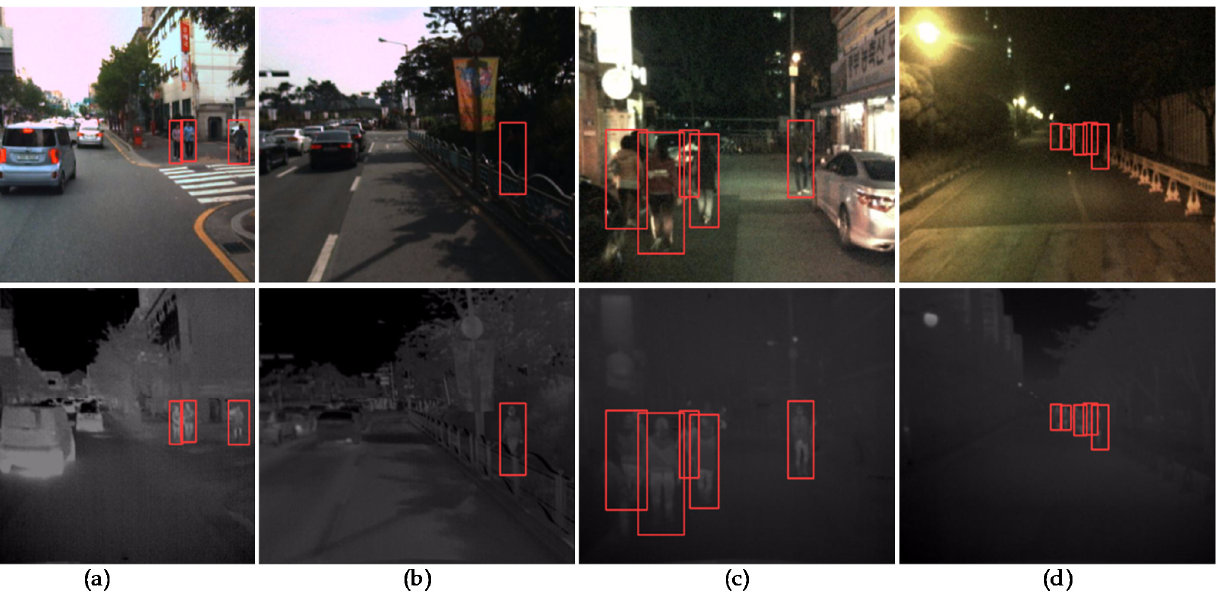
Figure 8. Visualization of images in the KAIST dataset. ( a ) Bright daytime scene. ( b ) Daytime scene with shadows. ( c ) Bright night scene. ( d ) Night scene.